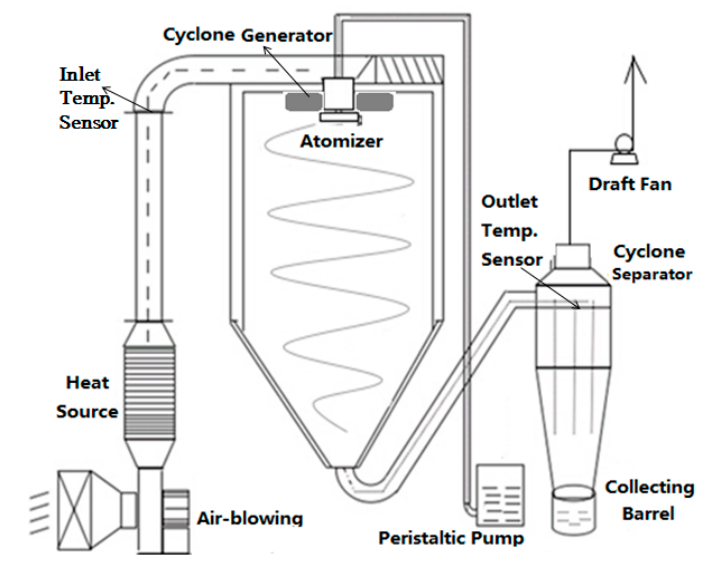
Figure 1. Schematic of a high-speed centrifugal spray dryer.